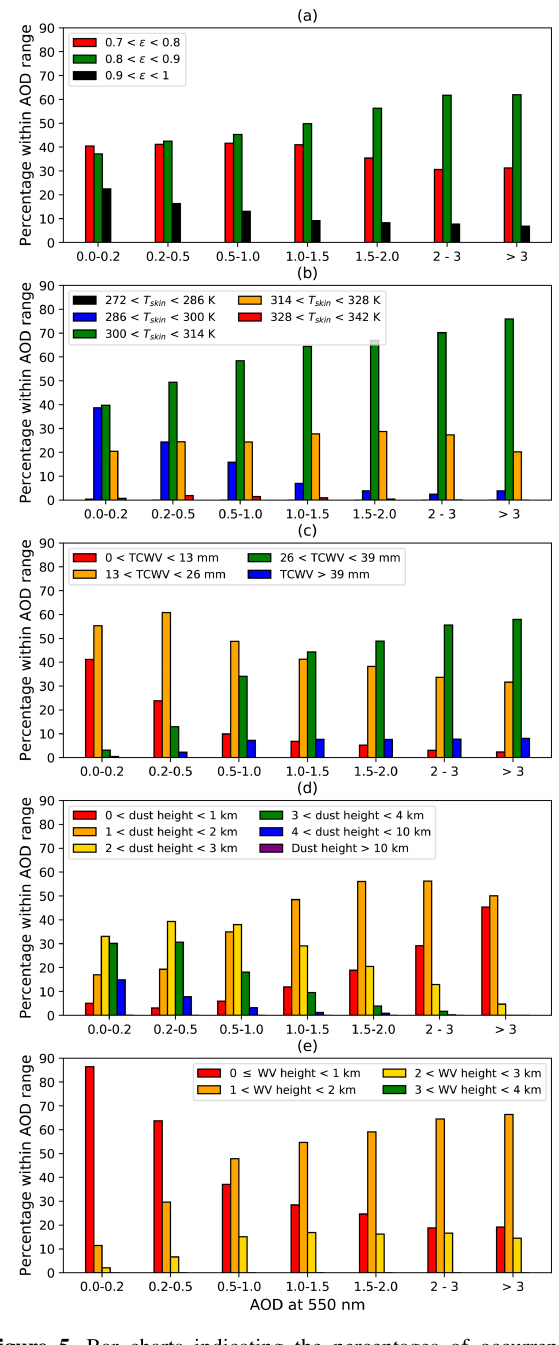
Figure 5. Bar charts indicating the percentages of occurrences of the subdivisions of the given properties, within ranges of the COSMO-MUSCAT AOD at 550nm. The time period is for the June and July of 2011–2013; all eight time slots are during the day. (a) Emissivity at 8.7µm; (b) skin temperature (K); (c) column moisture (mm); (d) dust height (km); (e) and water vapour (WV) height (km), defined here as the height above which there is less than 13mm of water vapour. Within each cluster of bars for a spec- ified AOD range, the sum of the bars is